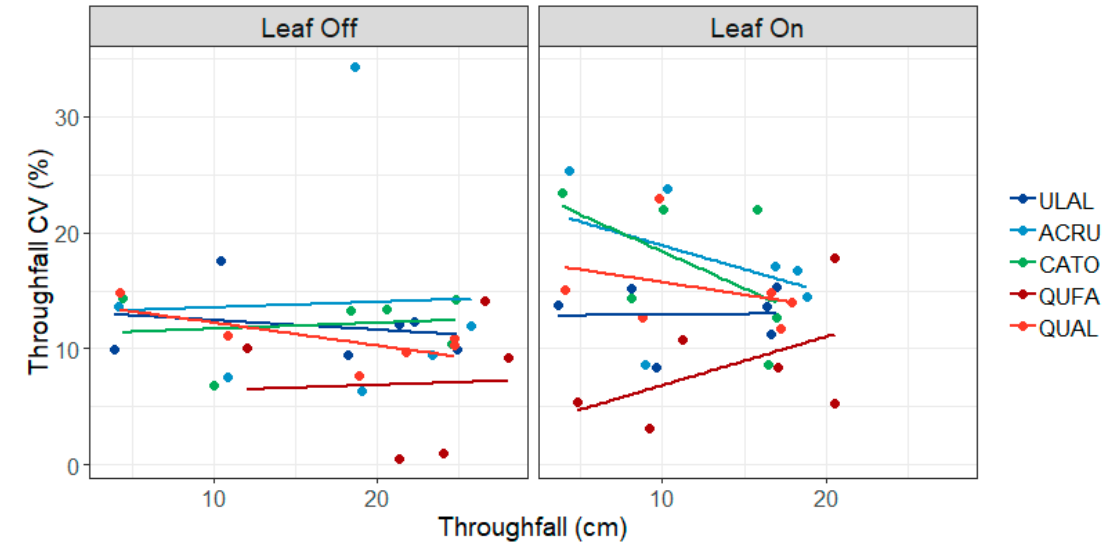
Figure 4. Coefficient of variation (CV) in midstory throughfall by leaf phase and species. Species codes: ACRU = red maple, ULAL = winged elm, CATO = mockernut hickory, QUFA = southern red oak, QUAL = white oak.